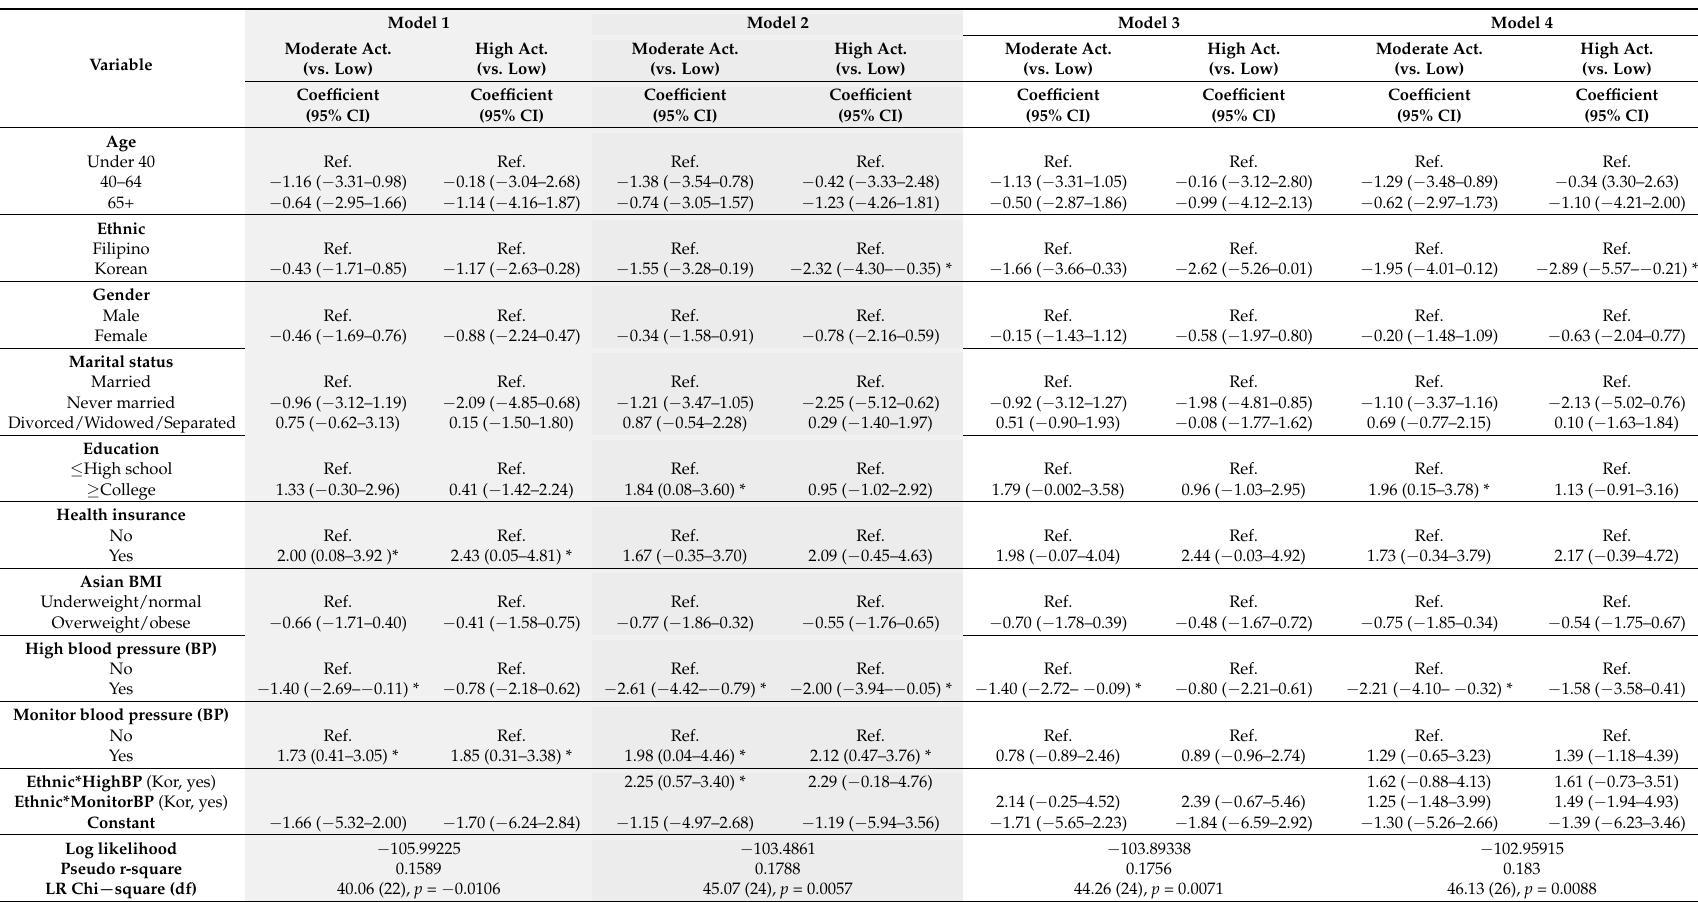
Table 4. Multinomial logistic regression analysis of demographic and acculturative factors and PA among Filipino and Korean Groups (n = 113).